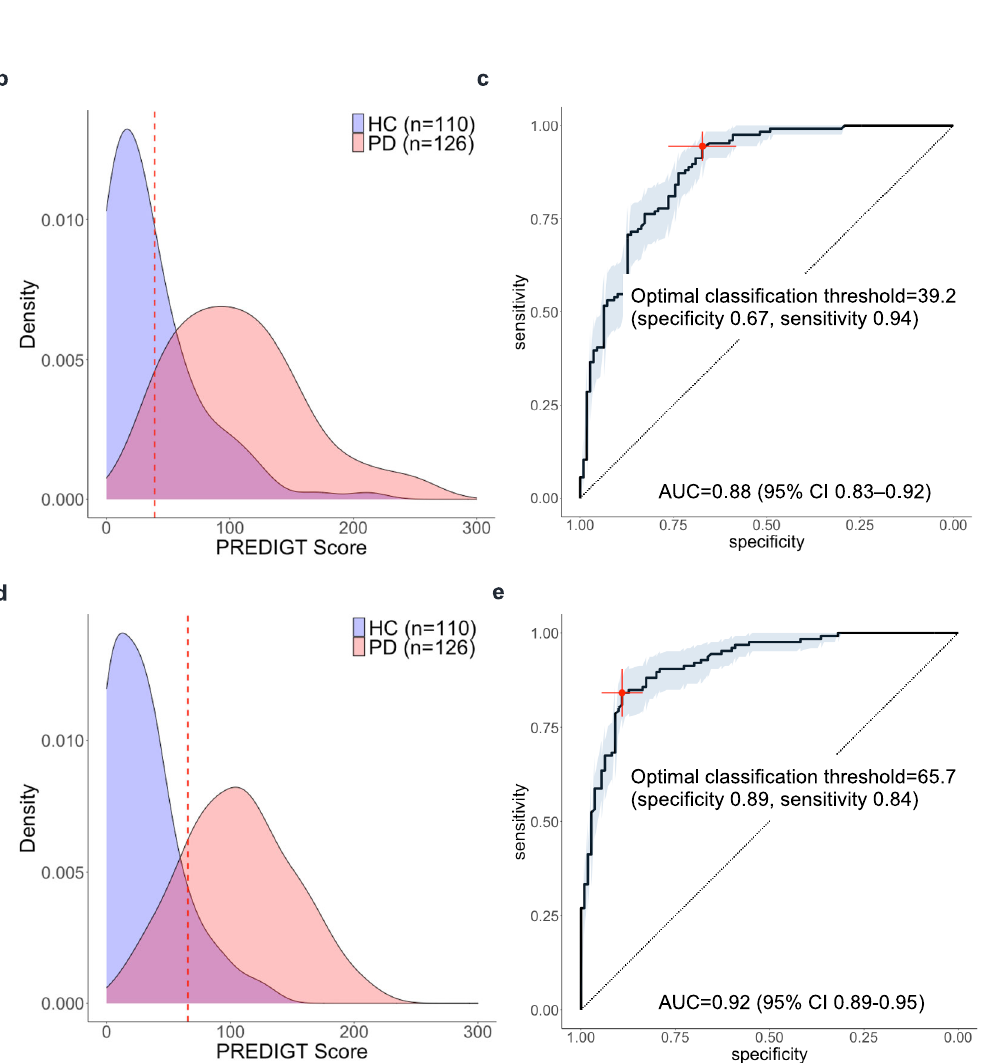
Fig. 3 Evaluation of the original PREDIGT Score in the DeNoPa cohort (Model 1; Model 1 ’ ). a Table of variables and their associated effect sizes, as gleaned from the OR [95% CI], the AUC values from corresponding univariate logistic regression analyses, and the number of subjects (with percentage, %) for positive cases in each group. Variables within each factor were listed in decreasing order of their AUC values; b , d score density plots of Model 1 and Model 1 ’ , respectively; c , e . ROC curves of Model 1 and Model 1 ’ , respectively. The red, dashed lines in panels b and d , and crosses in corresponding c and e indicate the optimal threshold (score, Model 1: 48.1, Model 1 ’ : 65.7) to distinguish the two groups by the maximum Youden Index. Light blue shading in the ROC curve indicates the bootstrap-estimated 95% CI. DeNoPa, De Novo Parkinson ’ s Study; n.a., data not available; OR odds ratio, CI con fi dence interval, ROC receiver operating characteristic, AUC area under the ROC curve, RBD REM sleep behavior disorder.